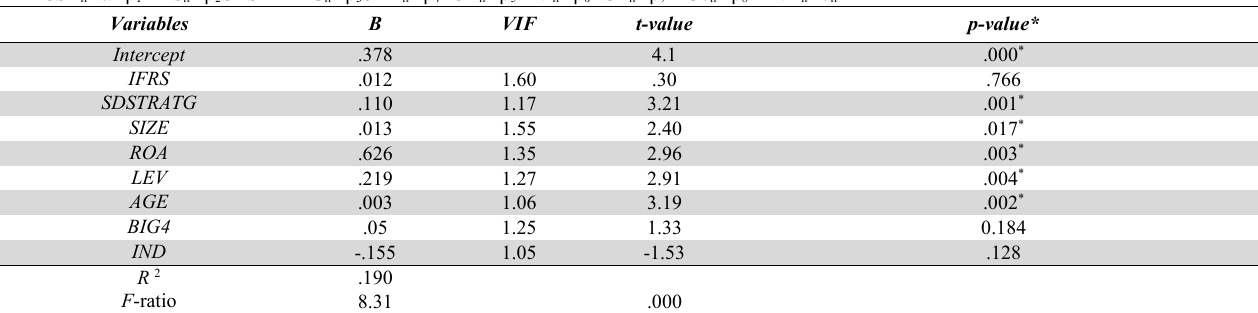
Regression results for